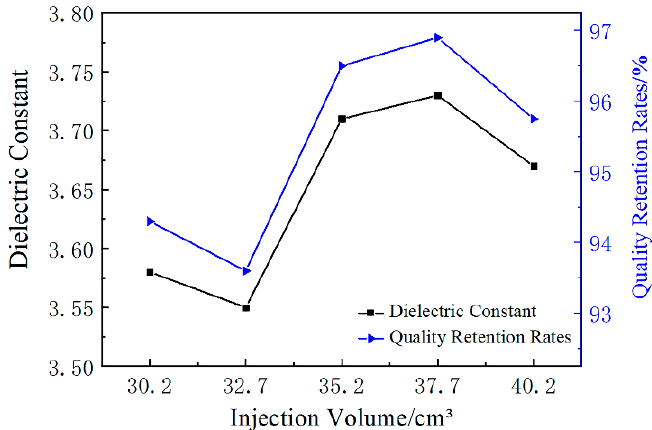
Figure 7. The dielectric constant and quality retention rates of GF / PA foams with di ff erent injection volume levels.